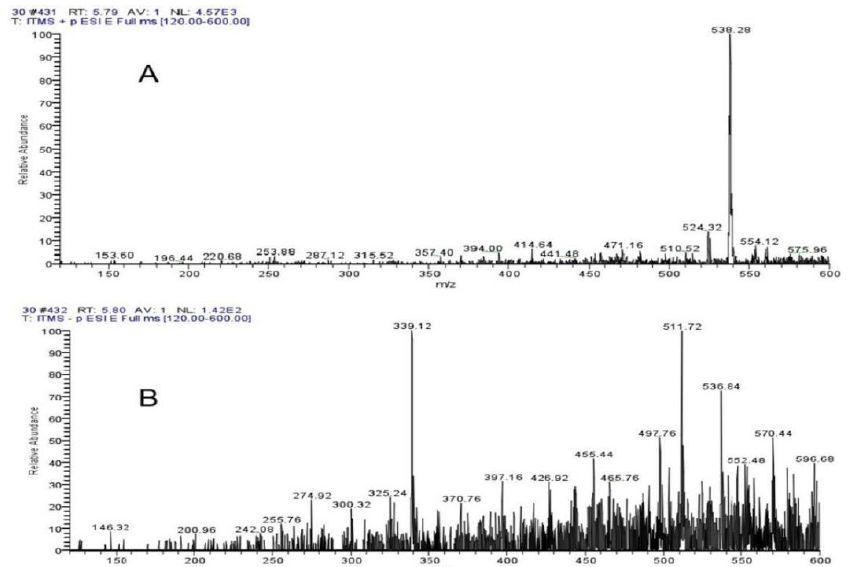
Figure 7. Mass Spectrogram analysis showed ( A ) 538.28 positive ions and ( B ) 536.84 negative ions at 5.39 min.